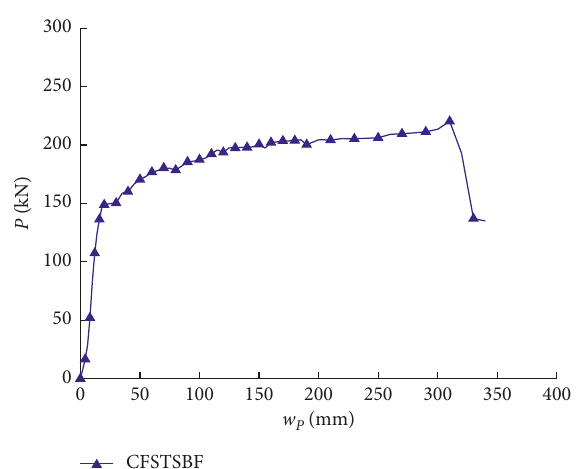
Figure 6: Analysis model in the elastoplastic stage.